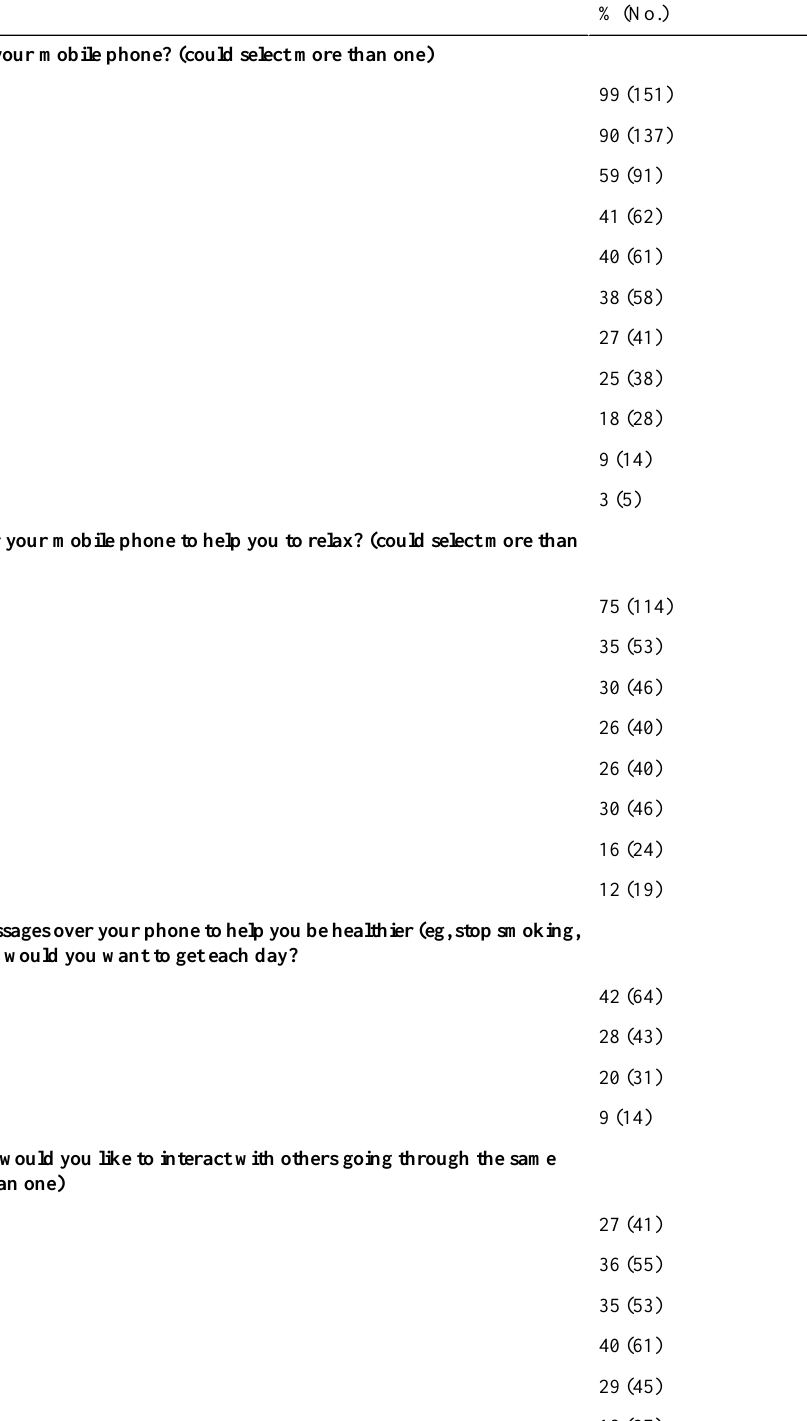
Table 1. Online survey results of participants’preferences for program content